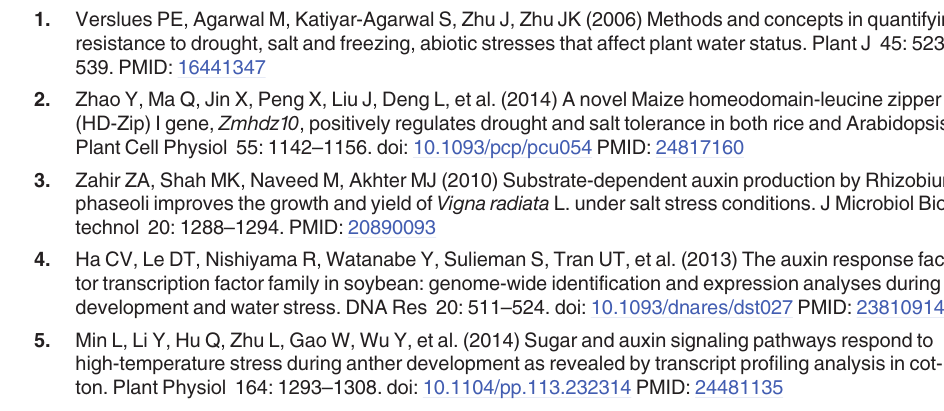
S2 Table. Spatial-temporal expression patterns of auxin transporter gene families based on digital expression data. S3 Table. The primer sequences of ZmLAX , ZmPIN , ZmPILS and ZmABCB genes. S4 Table. The values of the expression levels of all ZmPIN , ZmPILS , ZmLAX and ZmABCB genes. S5 Table. Number of stress-related cis -elements in the promoter regions of ZmPIN , ZmPILS , ZmLAX and Z mABCB